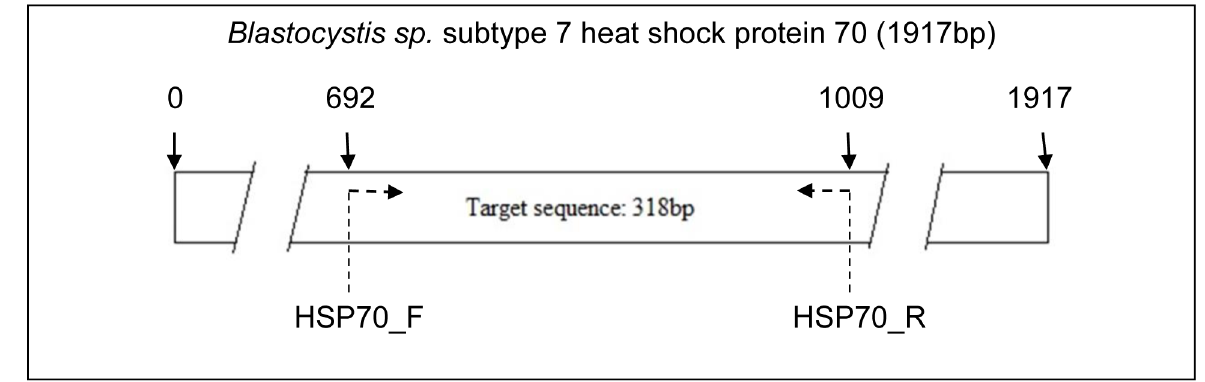
Figure 4. Localization of the target sequence in the Blastocystissp. heat shock protein 70 (HSP70) gene for subtype 7.